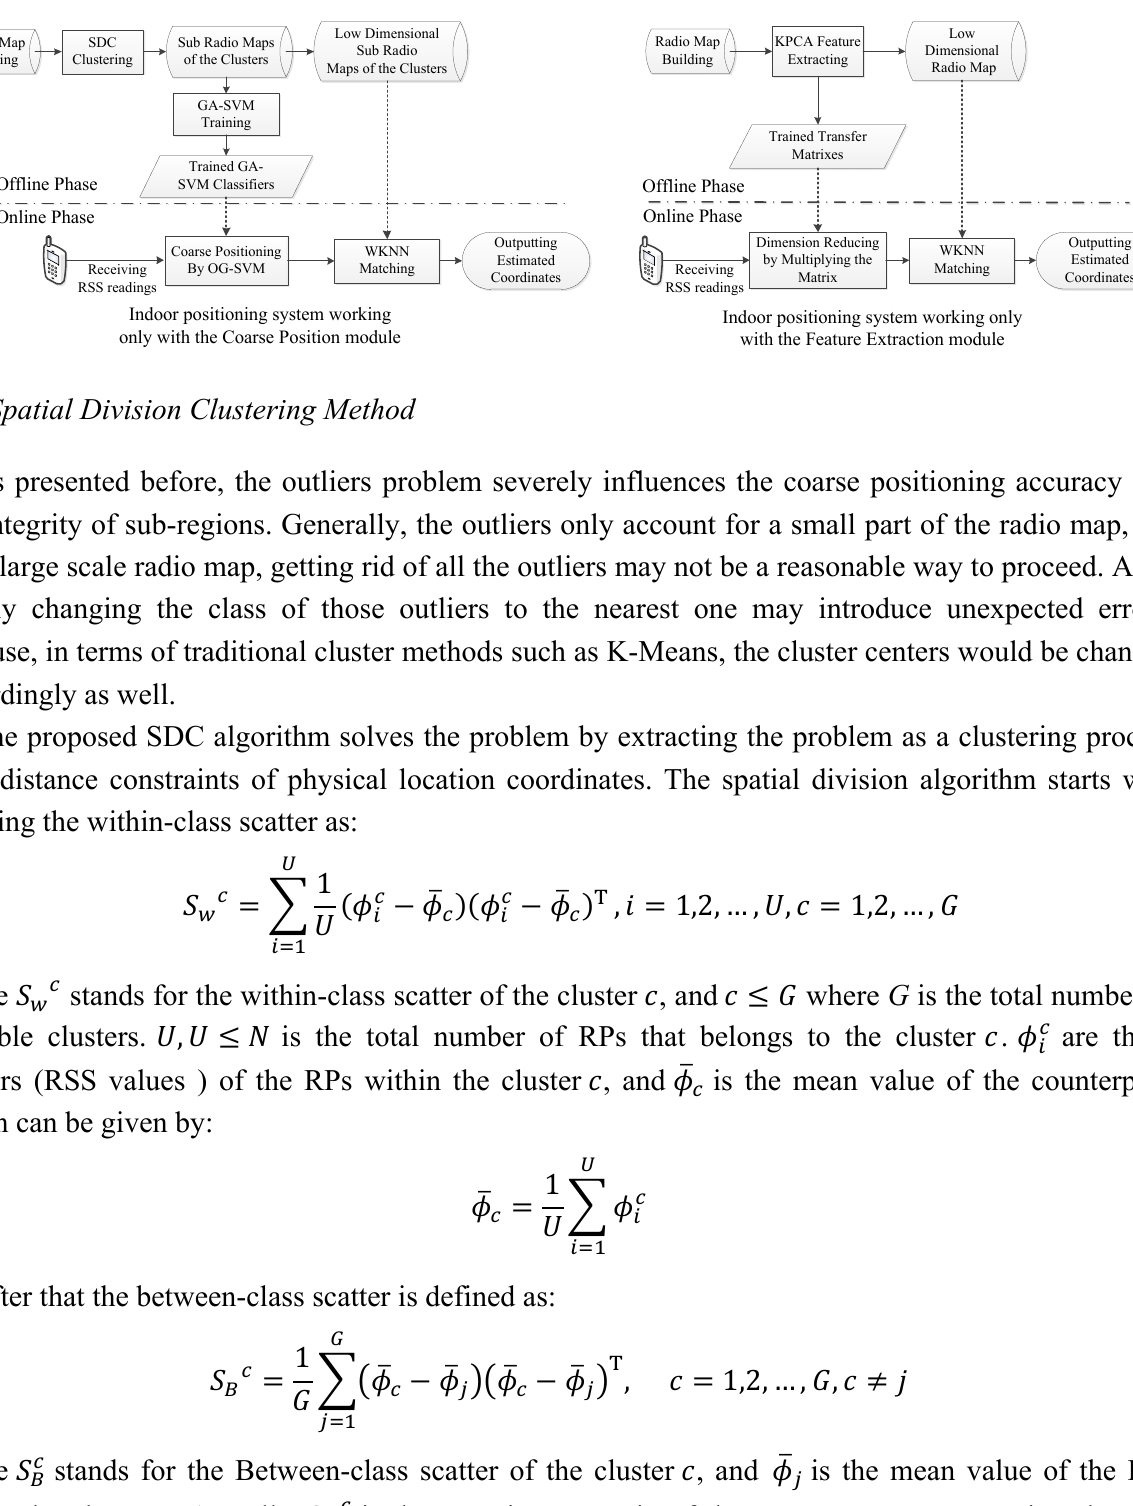
Figure 3. Flow charts of the indoor positioning system with a single